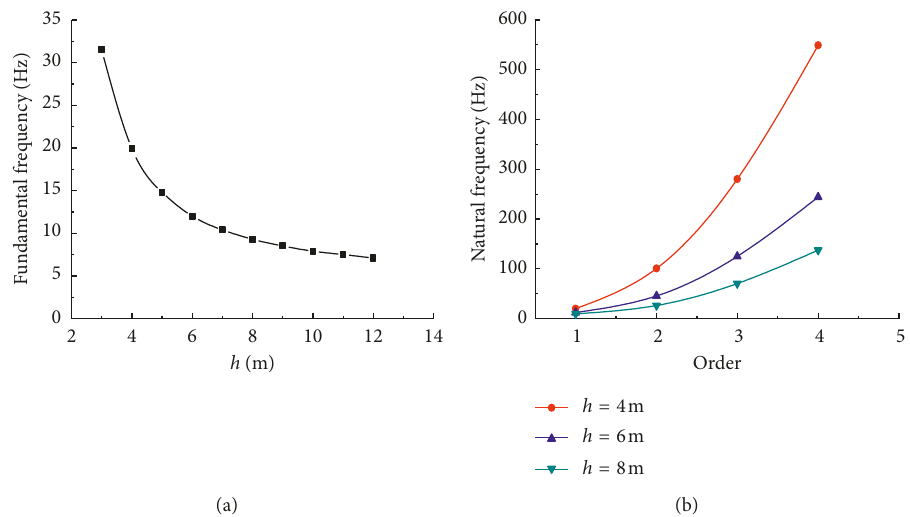
Figure 3: (a) Effects of wall height on fundamental frequencies; (b) effects of wall height on first four natural frequencies.